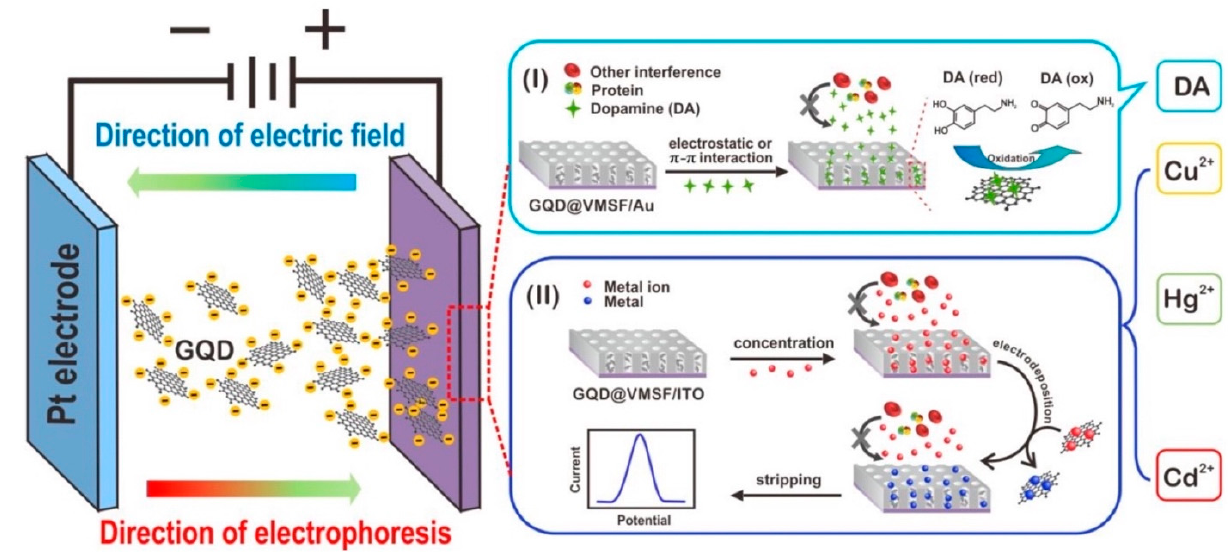
Figure 10. For the identification of Cd 2+ , Cu 2+ , and Hg 2+ ions, a GQD@mesoporous silica-nanochannel film (VMSF) was electrophoretically deposited on the electrode surface (Adapted from the Ref. [213] with the permission of ACS nano).